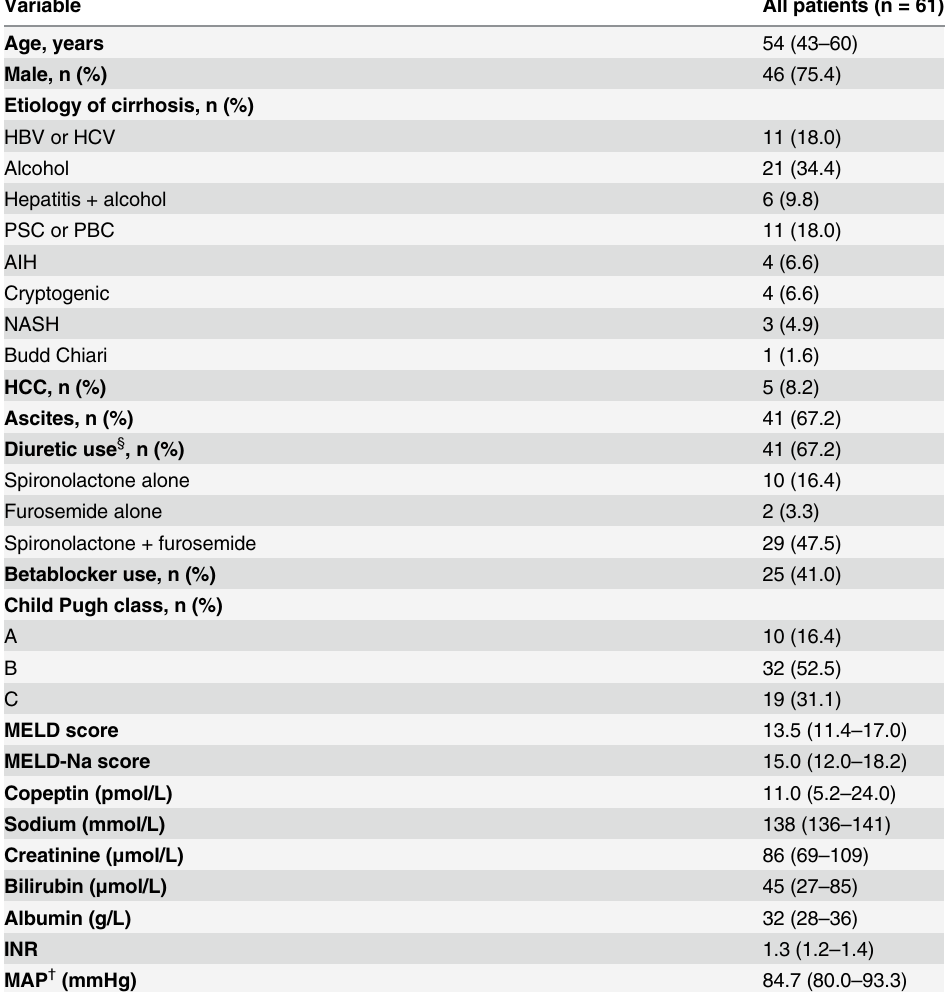
Table 2. Demographic and clinical characteristics of 61 cirrhotic patients at time of registration at the waiting list for liver transplantation. Variable All patients (n = 61)